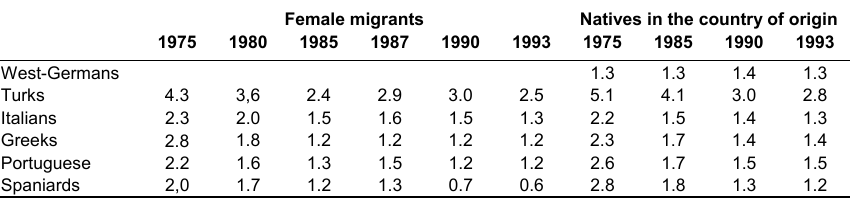
Table 4: Total fertility rates for West Germans and foreigners in the Federal Republic of Germany 1975-1993 Female migrants Natives in the country of origin 1975 1980 1985 1987 1990 1993 1975 1985 1990 1993